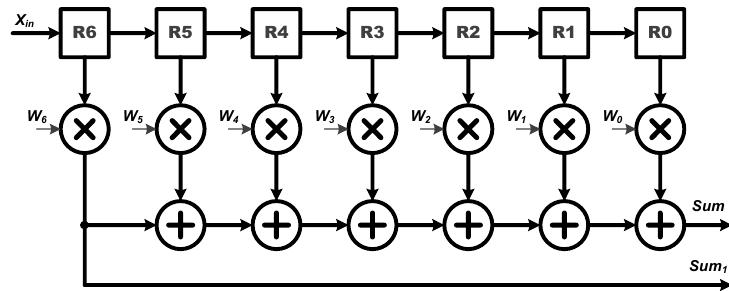
Figure 3. Architecture of the proposed PE module.